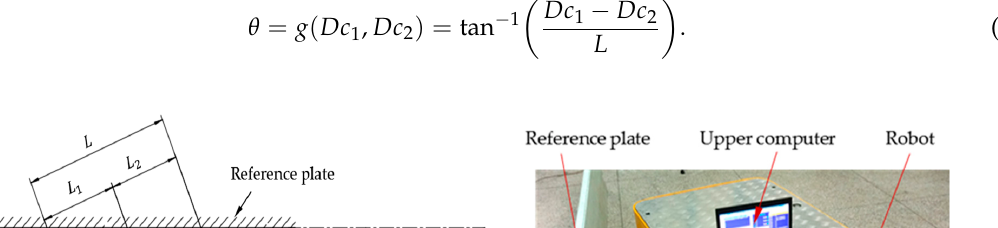
Figure 2. Lateral localization of a mobile robot. ( a ) The mathematical model of the localization application; ( b ) the practical application of lateral localization.